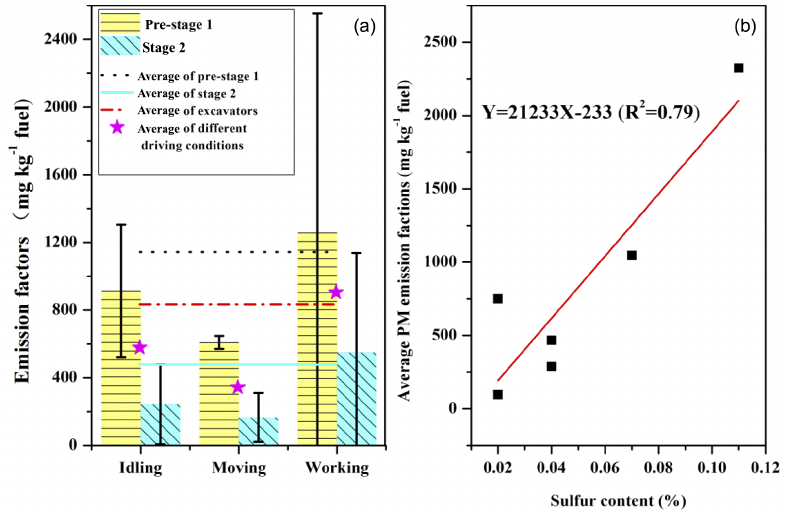
Figure 3. EF PM for excavators with different operational modes and emission standards (a) and the correlation with sulfur contents (b) .